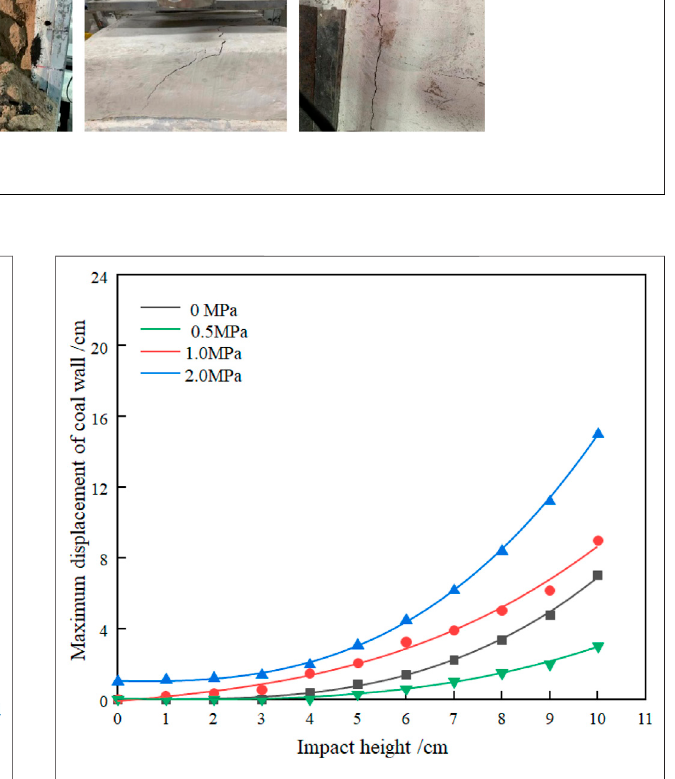
FIGURE 3 | Impact forces at different heights. FIGURE 4 | Coal wall displacement at different